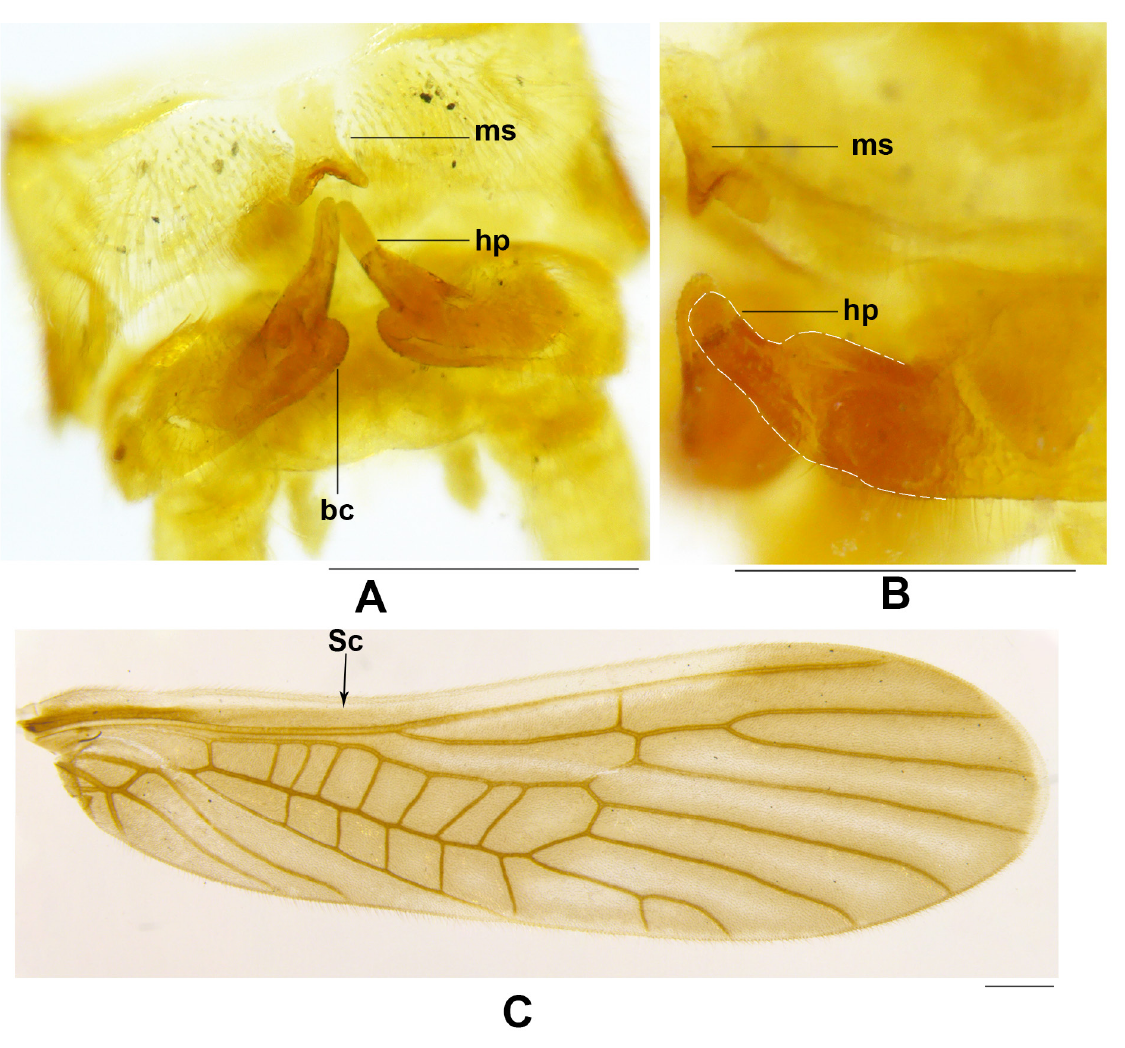
Fig. 8. Chinoperla nigrifrons (Banks, 1939). A–B . ♂, holotype of C. furcomacula (Wu, 1973) (IZCAS). A . Cleared terminalia, dorsal view. B . Cleared terminalia, lateral view. — C . ♂ from Mount Yinggeling (HIST), forewing. Abbreviations: see Material and methods. Scale bars = 0.5